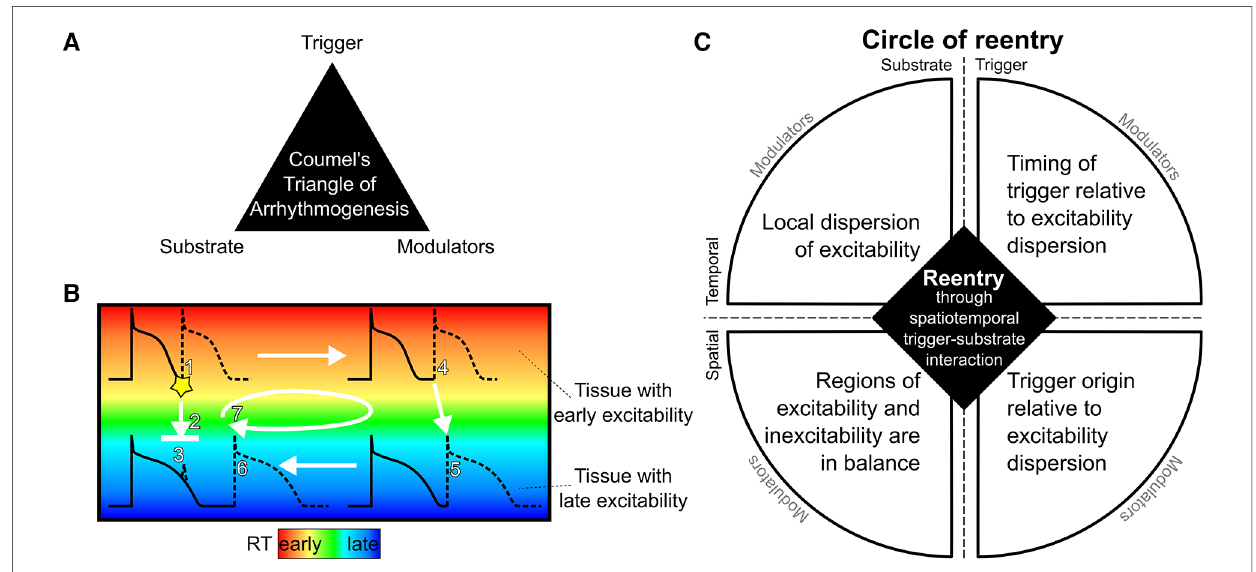
FIGURE 1 The circle of reentry hypothesis. ( A ): The Triangle of Arrhythmogenesis by Coumel identi fi es three major factors for arrhythmia initiation. ( B ): Schematic illustration of reentry in tissue with early and late repolarization time (RT) due to short or long action potential duration, respectively. A premature beat coming from an early RT region (1) may block against tissue that has a longer RT and is still refractory (2) and cannot induce activation in the late RT region (3). If the early RT region is large enough, the activation wave may propagate through that region (4) in a time span that allows the late RT region to repolarize and become excitable, allowing re-activation of the tissue (5). The wave may then travel back to the region that was still refractory but which has become excitable in the meantime (6). By that moment, the tissue from which the premature beat originated has become excitable again, and the wavefront from the late RT region will propagate to that tissue, restarting this circuit (7). ( C ): The Circle of Reentry proposes four requirements for reentry arising from spatiotemporal interactions between trigger and substrate: (1) local dispersion of excitability (e.g., steep RT gradients), (2) a balance in size of the region of excitability and the region of inexcitability (e.g., suf fi ciently large region of early RT), (3) a trigger originating at a time when some tissue is excitable and other tissue is inexcitable (e.g., an early premature beat), and (4) which occurs from an excitable region (e.g., from early RT region). Each of the four elements can be affected by